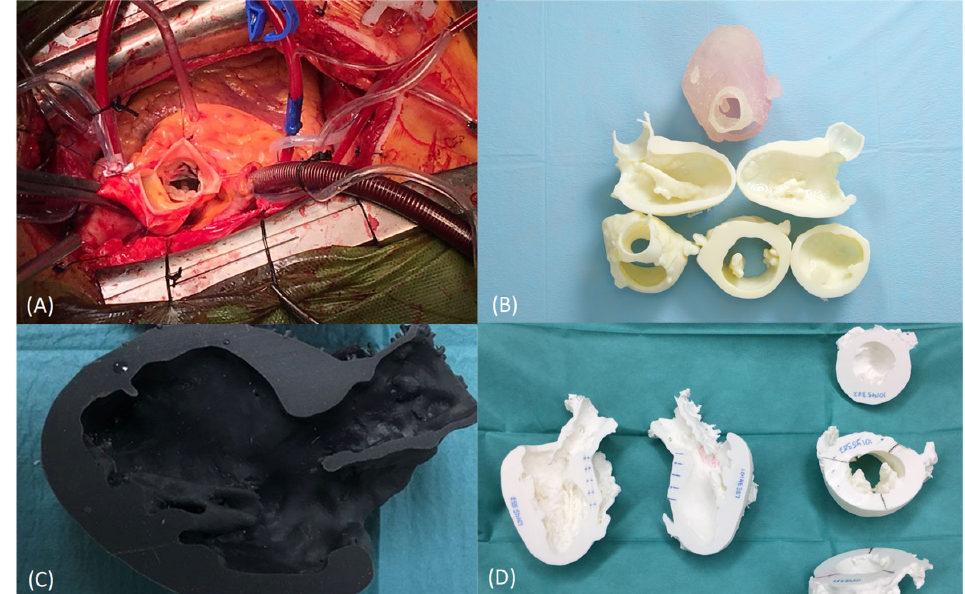
Figure 3. Anatomical model for planning, training, teaching and patient communication of obstruc- tive hypertrophic cardiomyopathy (cardiovascular Surgery). ( A ) Surgical field and intraoperative vision in HCM surgical treatment. ( B ) Three-dimensional anatomical models for HCM planning, with pieces that represent the short axis and 3 chambers, manufactured by MJ technology. ( C ) A 3D anatomical model for HCM planning, showing a piece that represents longitudinal cutting of one chamber, manufactured by SLA technology. ( D ) Height and depth references of the resection to be performed on the cardiac wall, painted on the printed anatomical biomodel. References are painted on the diathermy loop itself.